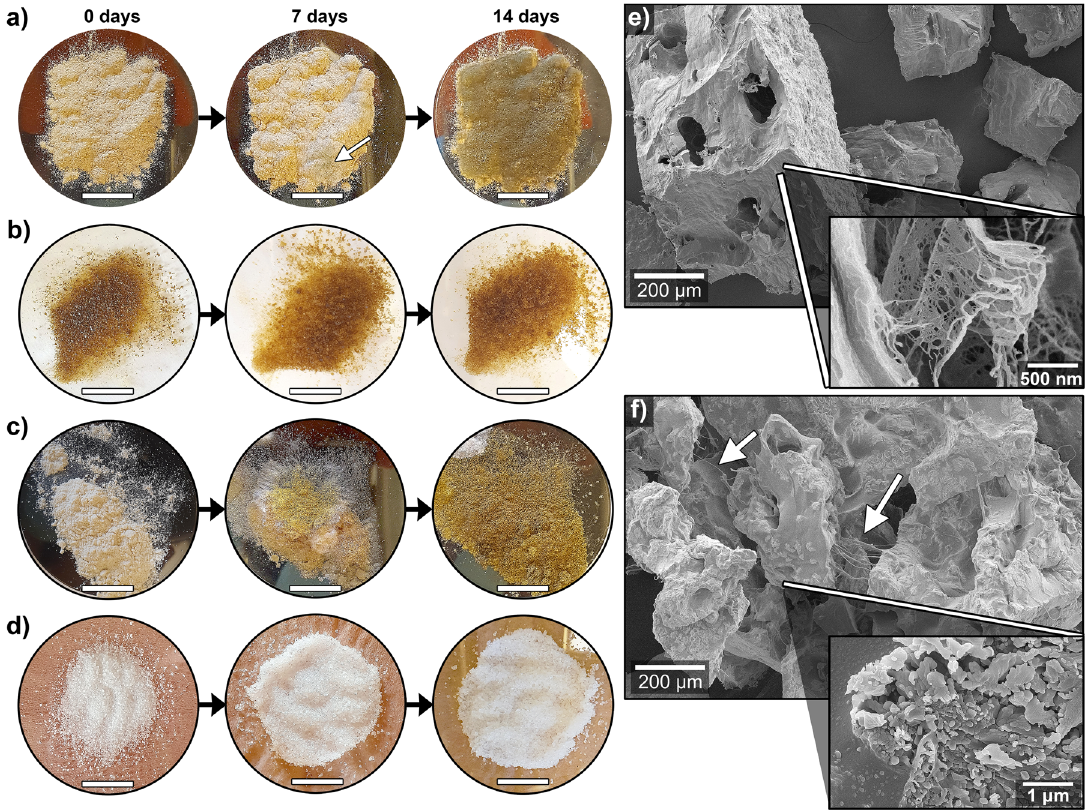
Fig. 4 Mould growing and sample morphology. Samples exposed to 100% RH: a , PPC, b PPC/25ED, c WG, d SAP. The white arrow in a point mould growing sites. e Images of PPC/25ED, and f commercial SAP particles after being exposed two weeks to 100% RH and then lyophilised. The white arrows in f point at some of the observed fi laments connecting the SAP particles. The scale bar in the photographs represents 1 The PPC and wheat gluten (WG) reference material showed without any apparent mould growth on the powder after 2 weeks rapid mould growth on the powder after 2 weeks of exposure to exposure to 100% RH, Fig. 4b, d, respectively. This property was 100% RH, as shown in Fig. 4a, c, respectively. In contrast, the also obtained for PPC/Ref, which resisted mould growth even PPC/25ED visually resembled the synthetic SAP material, i.e., after 2 weeks of being in contact with the as-received PPC that